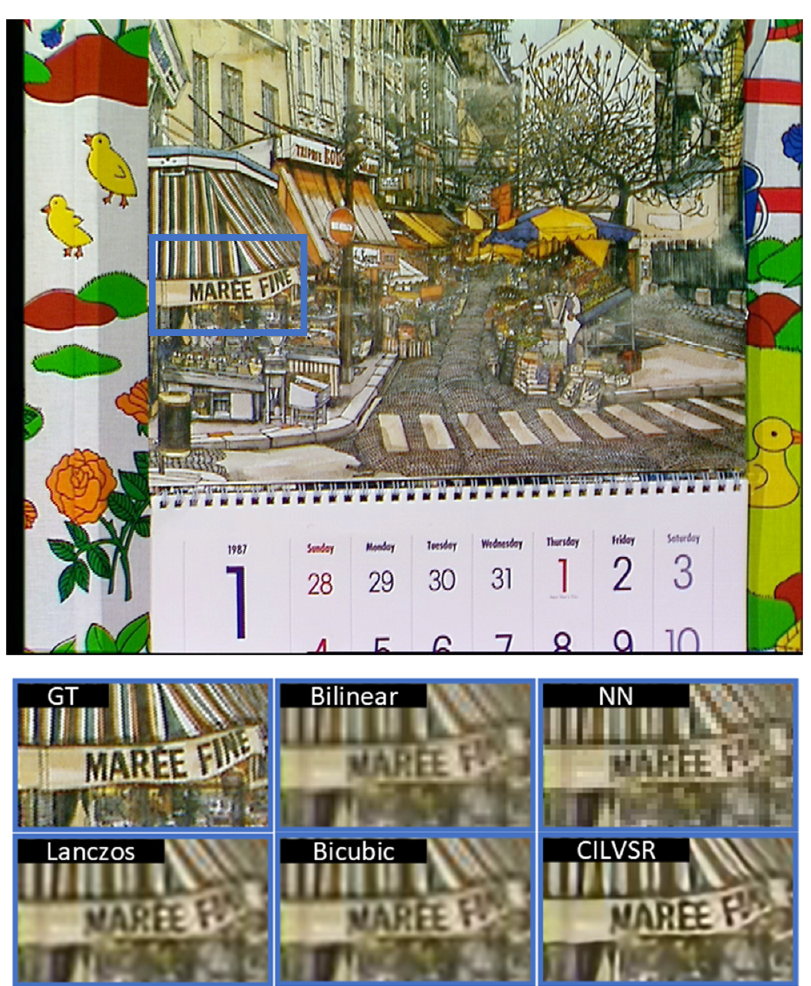
Figure 5. Visual comparison of 3× upsampling results on image sample “Calendar” , ground truth (GT), bilinear, nearest neighbor, Lanczos [58] , bicubic [57] , and CILVSR.